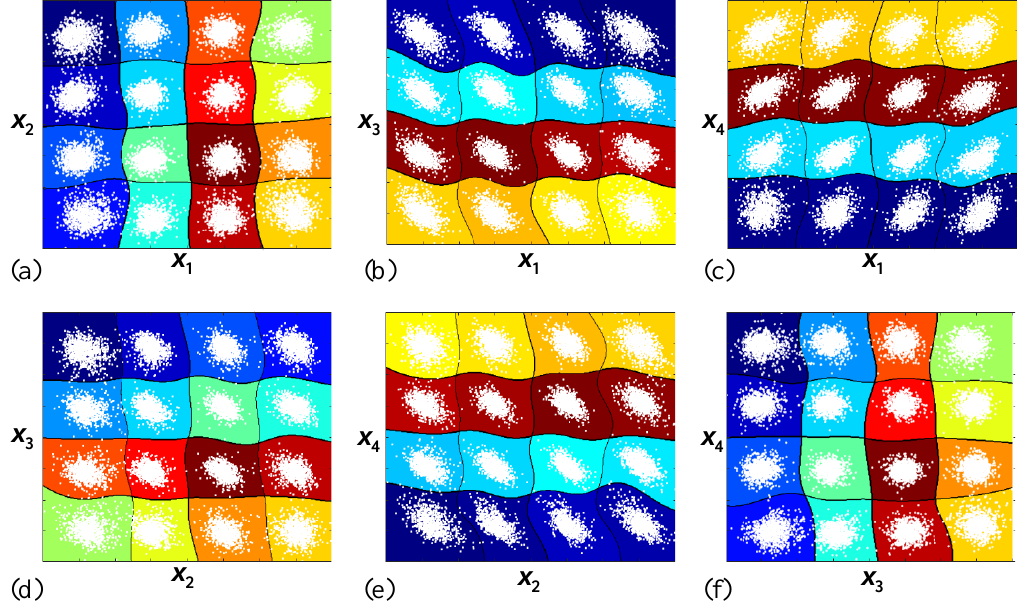
Figure 8. ( a – f ) are the projection of 4-D constellation points on a 2-D plane and the SVM-based soft decision